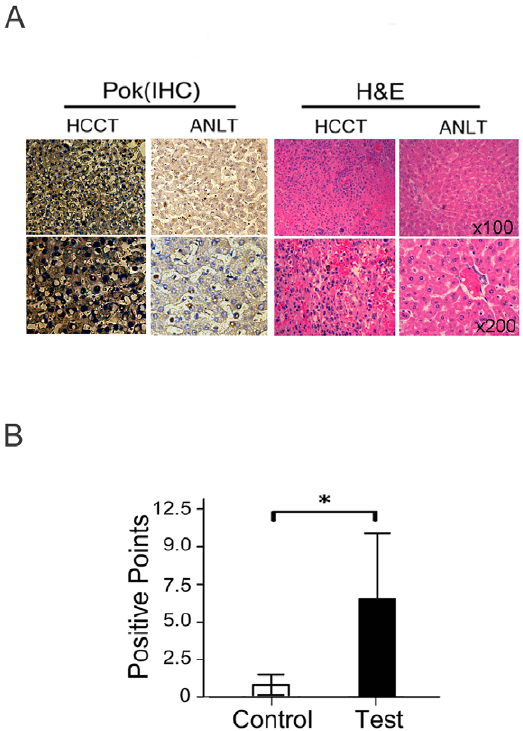
Figure 1. Immunohistochemical analysis of Pokemon expres- sion in HCC tissue (Test Group) and adjacent noncancerous liver tissue (Control Group). ( A ). Typical representative immuno- histochemical results from one pair of HCC tissue (HCCT) and adjacent noncancerous liver tissue (ANLT) using an anti-Pokemon antibody. Pokemon was stained brown in granules. ( B ). A bar graph representing the relative expression level of Pokemon in the HCCT and ANLT groups, as evaluated by positive staining points. (A paired-samples t -test was used to compare the data from the two groups, * P , 0.01).